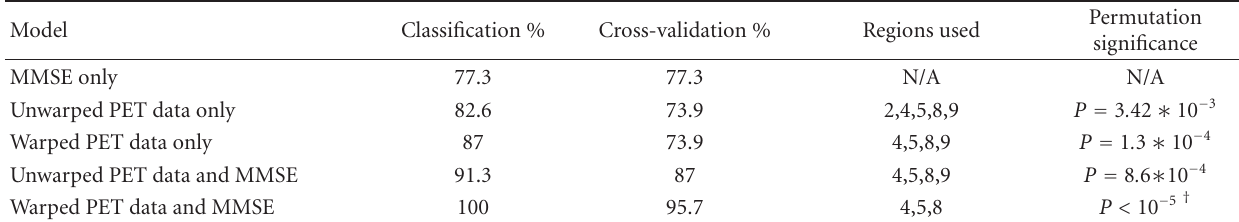
Table 1: Best discriminant models.